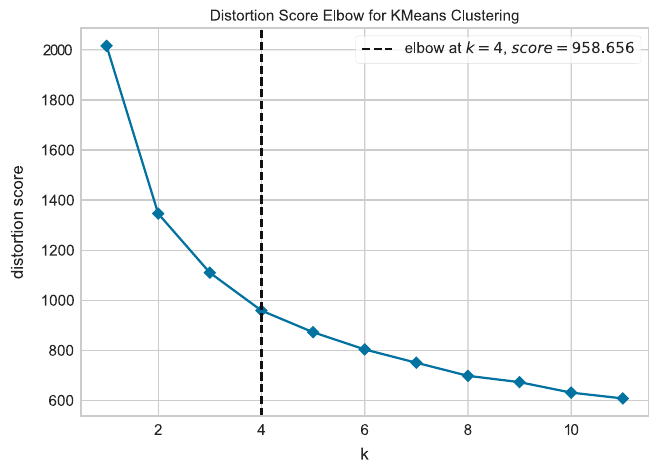
Fig. 4 Overlaps in related research